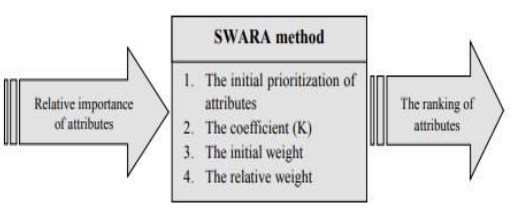
Figure 2. The Framework of SWARA Method Source: Alinezhad & Khalili, 2019